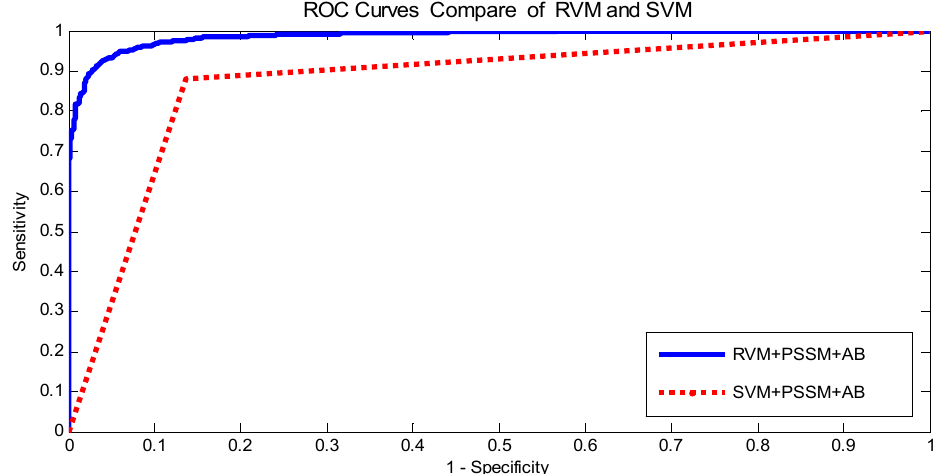
Figure 1. Comparison of Receiver Operating Curve (ROC) curves performed between Relevance Vector Machine (RVM) and support vector machine (SVM) on yeast dataset.